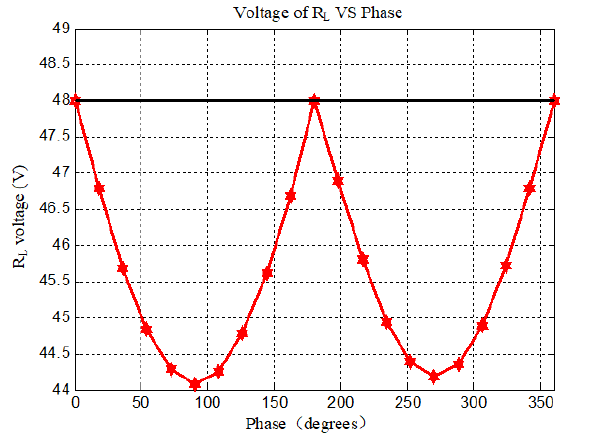
Figure 17. Voltage on R L vs.